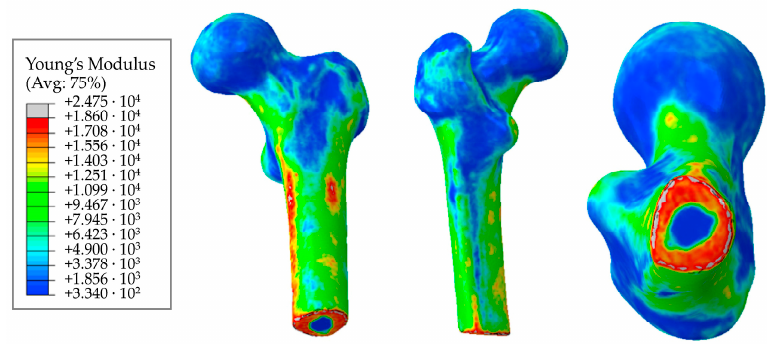
Figure 15. Distribution of elastic moduli in the femur, MPa.